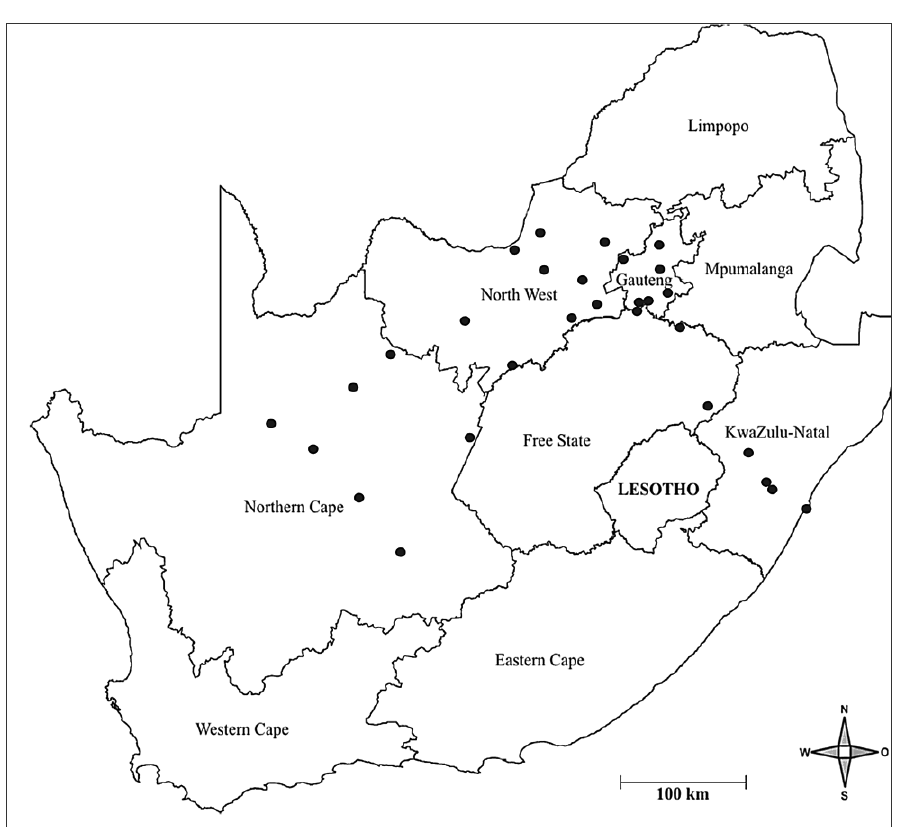
Figure 1 Sample sites in